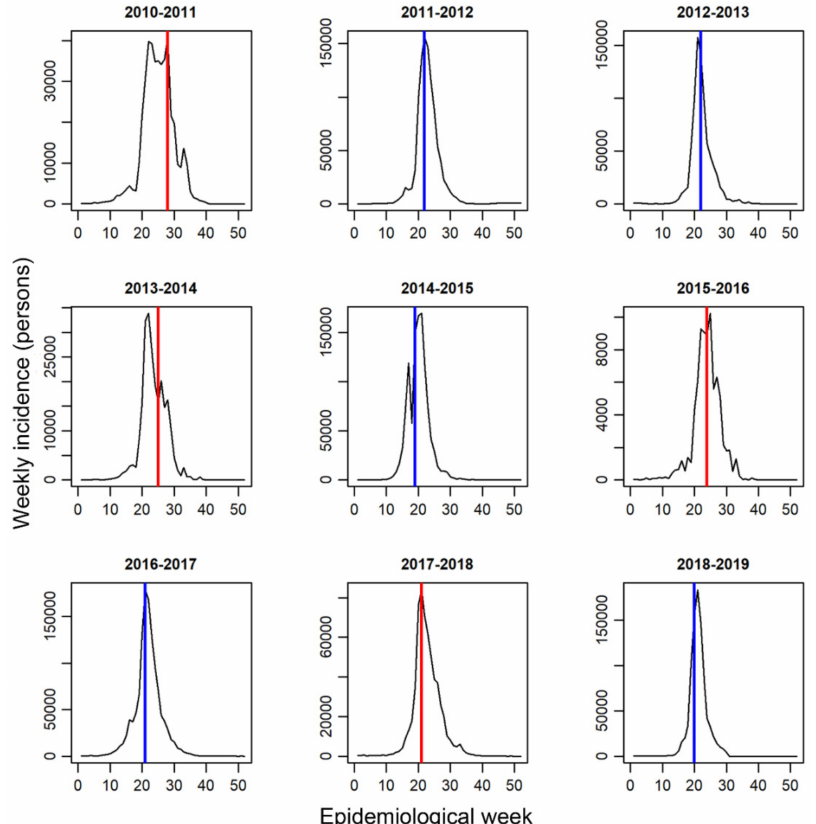
Figure 2. Temporal distribution of the weekly incidence proxies for influenza A / H3N2 from 2010 to 2019. Epidemic week 1 corresponds to calendar week 36. Blue lines indicate the week at which the prediction of the epidemic size took place in each season, corresponding to the time at which the sum of the incidence of influenza A / H3N2 in the past 5 weeks exceeds the statistically chosen threshold h = 480,000 cases. Red lines indicate the prediction timing, corresponding to the time at which the complementary cumulative incidence from week 1 exceeds the chosen threshold h c = 700,000